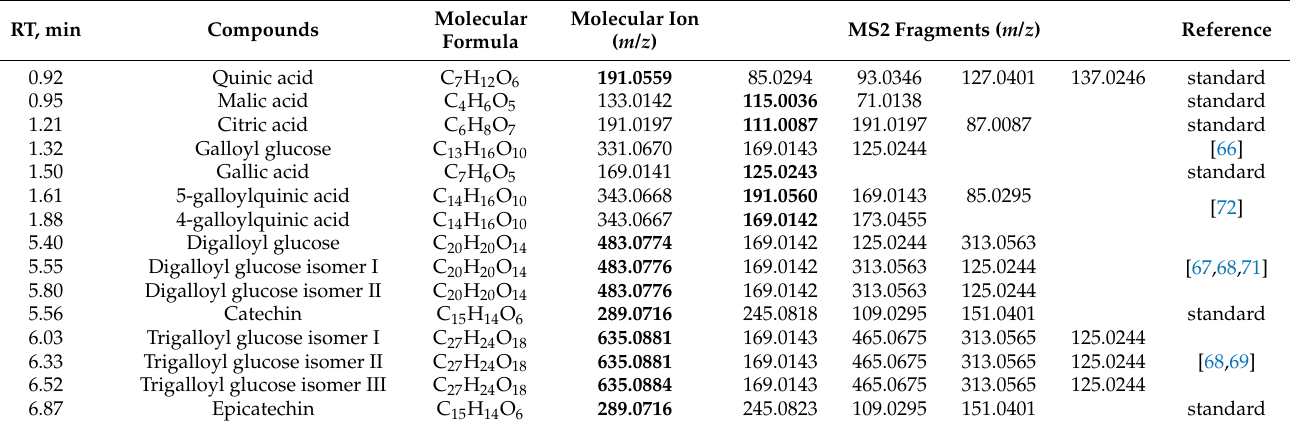
Table 7. High resolution accurate mass data of identified compounds in negative